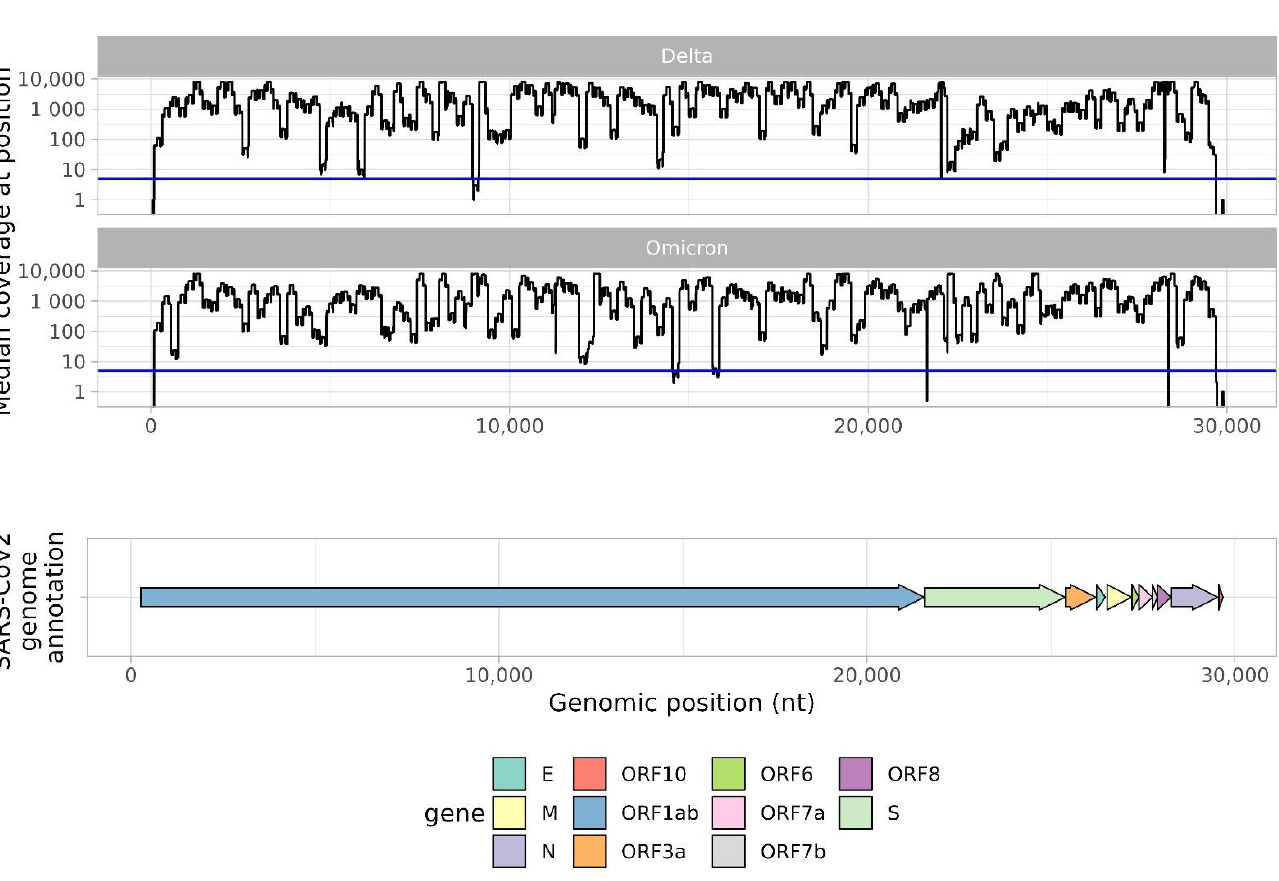
8 of 16 Figure 4. Comparison of SNP detection between different library protocols using all 40 samples. Panel ( A ) shows the presence of SNPs by genomic position (blue bars). The x -axis shows genomic